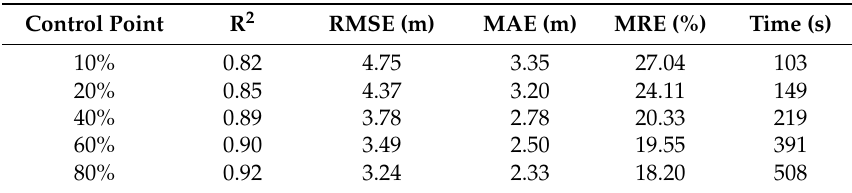
Table 6. Error statistics of di ff erent trainset size.